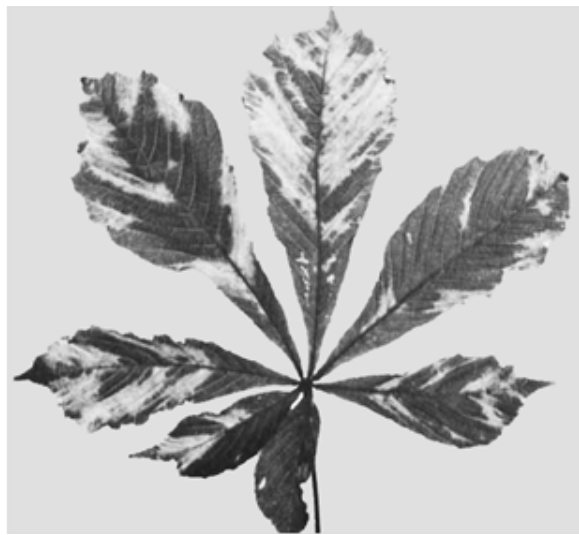
Figure 4. Symptoms associated with infection by ApMV in the form of line patterns on chestnut tree leaves (Sweet and Barbara, 1979). Photo provided by Annals of Applied Biology